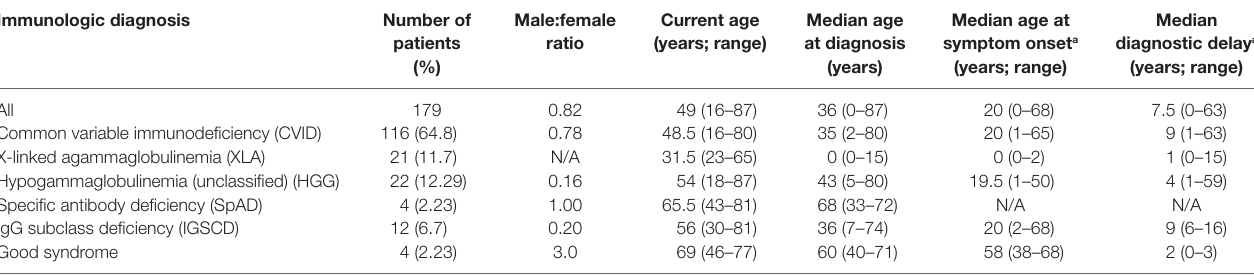
TaBle 1 | Diagnostic and demographic data of the Victorian adult predominantly antibody deficiency